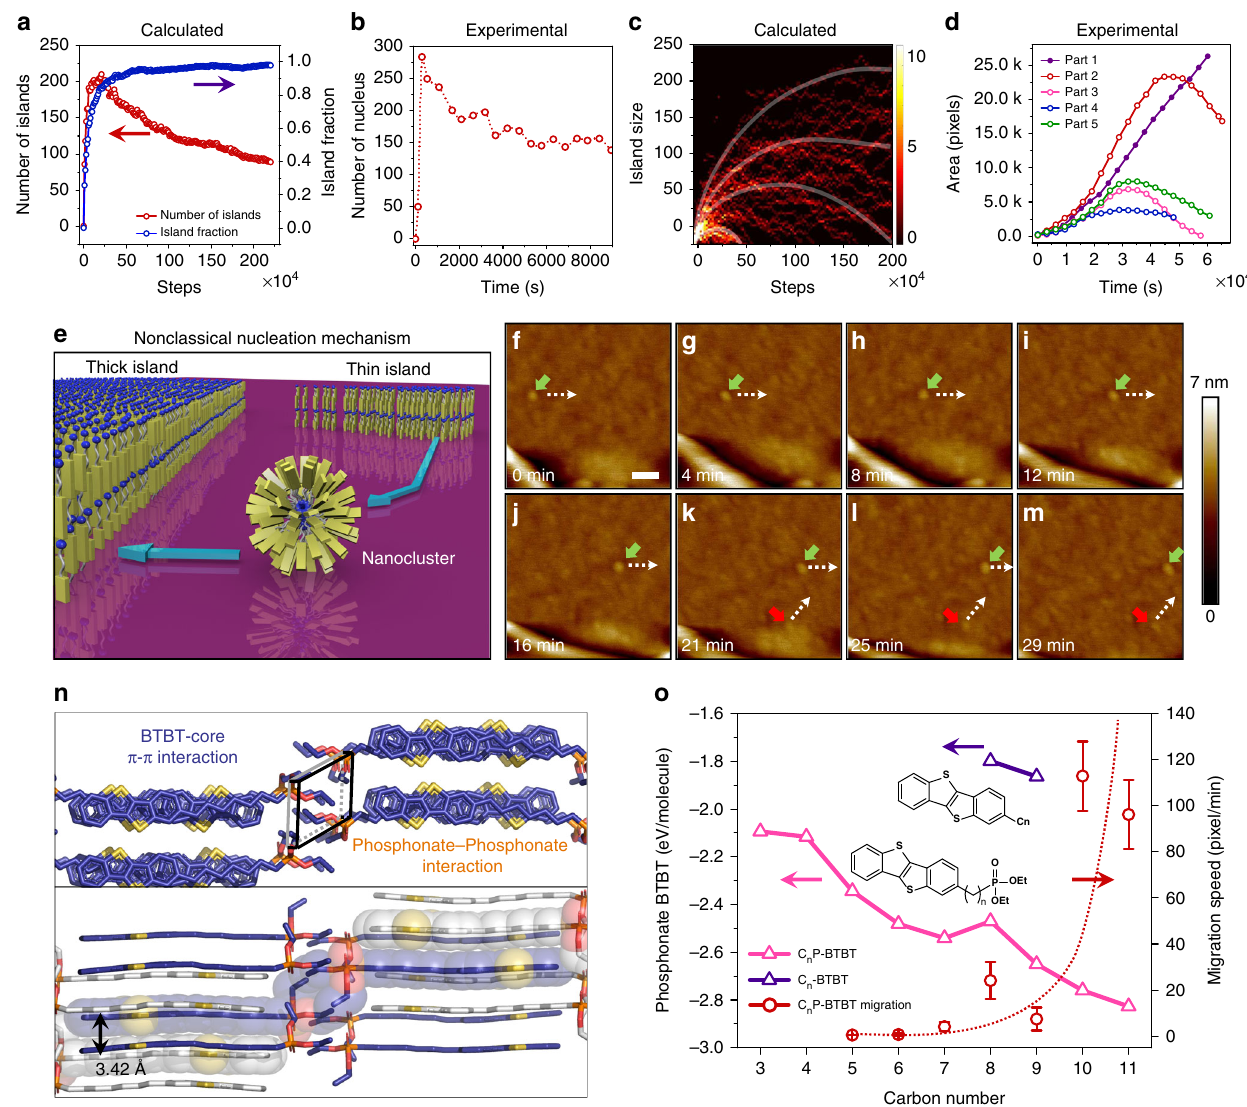
Fig. 4 Experimental evolution of C 7 P-BTBT islands in comparison with kinetic Monte Carlo simulations. a , b Comparison between simulated ( a ) and experimental ( b ) time-dependent number evolutions of total islands. c , d Comparison between simulated ( c ) and experimental ( d ) time-dependent evolutions of the island area. e Schematic illustration showing the nanocluster-involved nonclassical nucleation mechanism. f – m High-resolution AFM images showing evidence of the spherical molecular cluster as mass transport carriers on the surface (green and red arrows marked two nanoclusters; white dash arrows marked the moving directions). Scale bar: 50 nm. n Single-crystal structure of C 7 P-BTBT showing the BTBT-core π – π interaction and phosphonate – phosphonate coupling (top), and the compressed π – π stacking distance of 3.42 Å (bottom). o Binding energy calculation results for C n P- BTBT ( n = 3 – 11) (pink triangle), C n - BTBT ( n = 8 and 9) (blue triangle) and corresponding growth rates of C n P-BTBT ( n = 5 – 11) (red circle). Error bars are standard deviations of migration speed measured from multiple